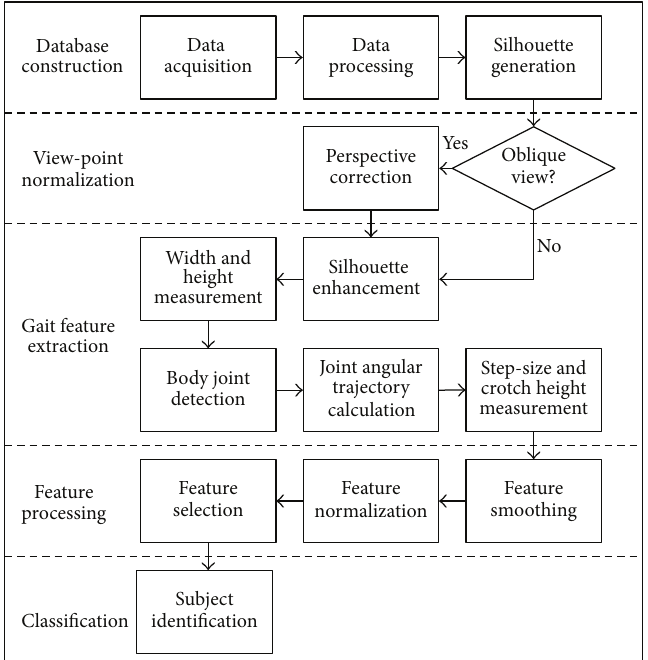
Figure 1: Proposed processes flowchart.